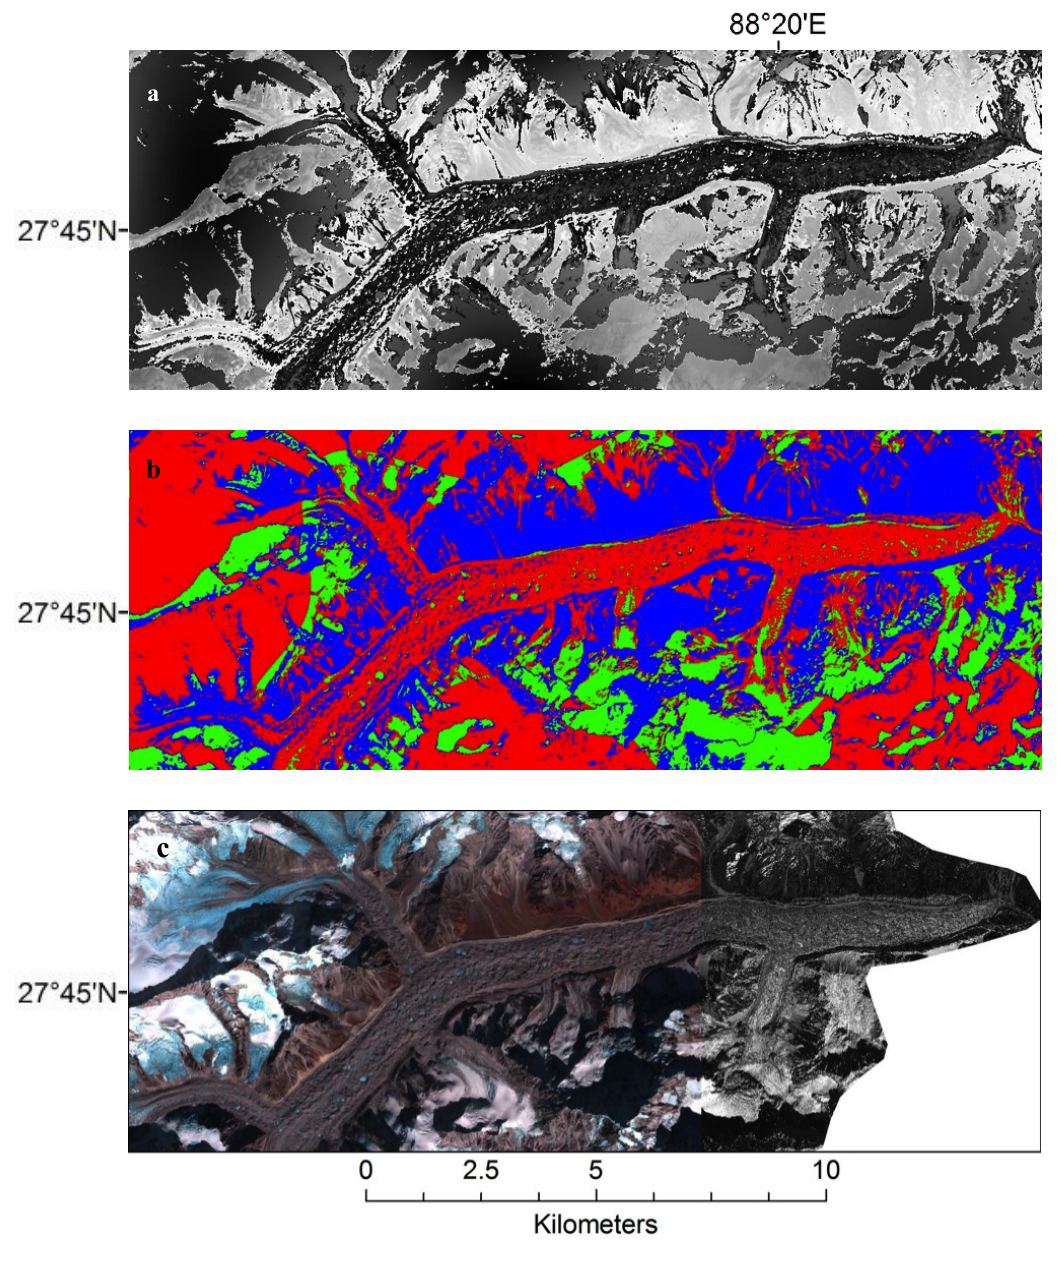
Figure 15. ( a ) Inverse FFT image obtained from band 1 of ASTER, using a circular cut filter; ( b ) unsupervised classification applied to the inverse FFT image. Clean ice and debris-covered areas are depicted in red; surrounding periglacial moraines in magenta; ice in shadow and supraglacial lakes in green; ( c ) color composite of QB 432 and black and white WV2 imagery for the Zemu glacier, shown here for visual